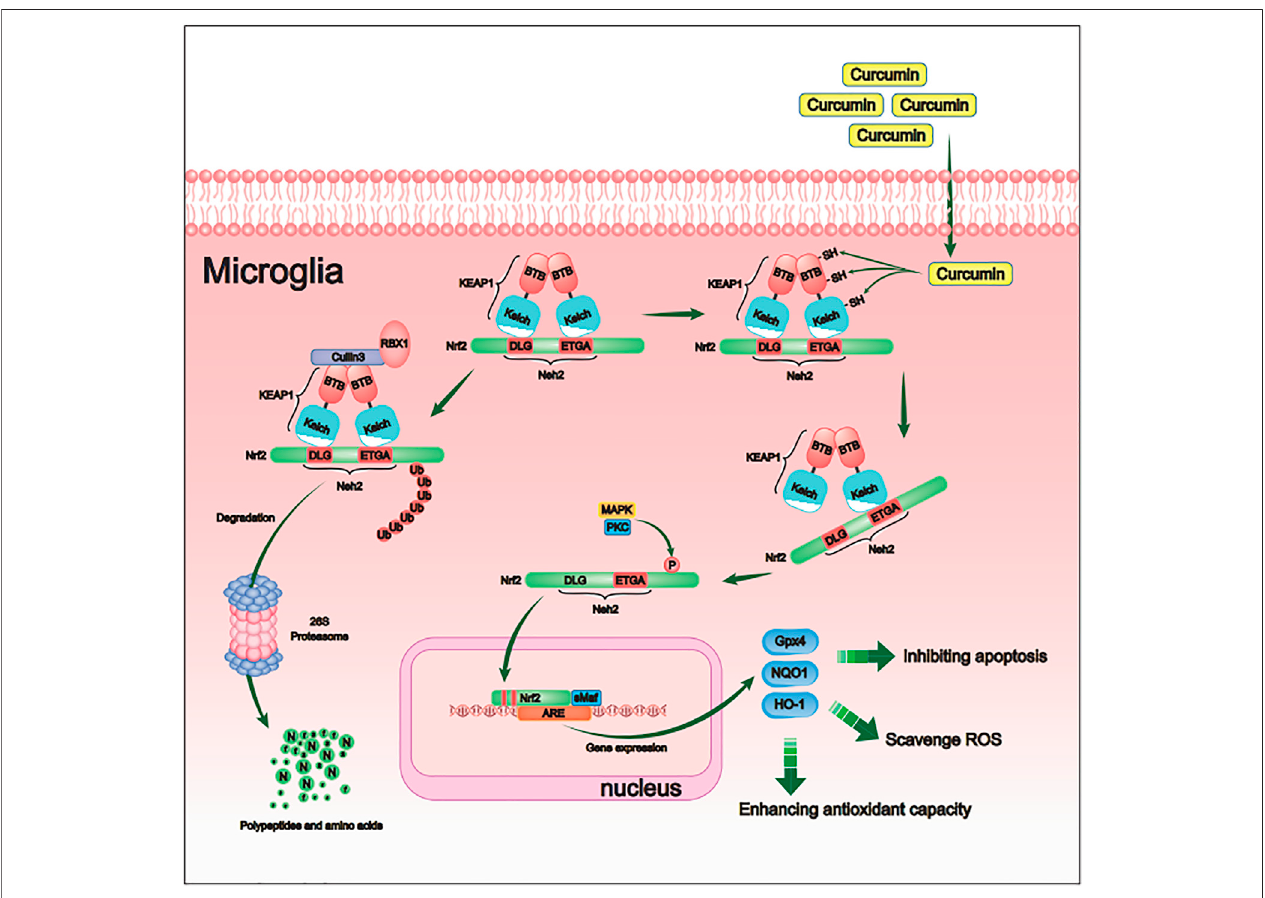
FIGURE 9 | Schematic diagram of the molecular mechanism by which curcumin promotes antioxidant activity of intracranial microglia after intracerebral hemorrhage. By activating the Nrf2/ARE pathway, curcumin promoted the expression of many downstream antioxidant-related genes (including HO-1, NQO1, and Gpx4). Therefore, curcumin inhibited the cerebral oxidative injury after